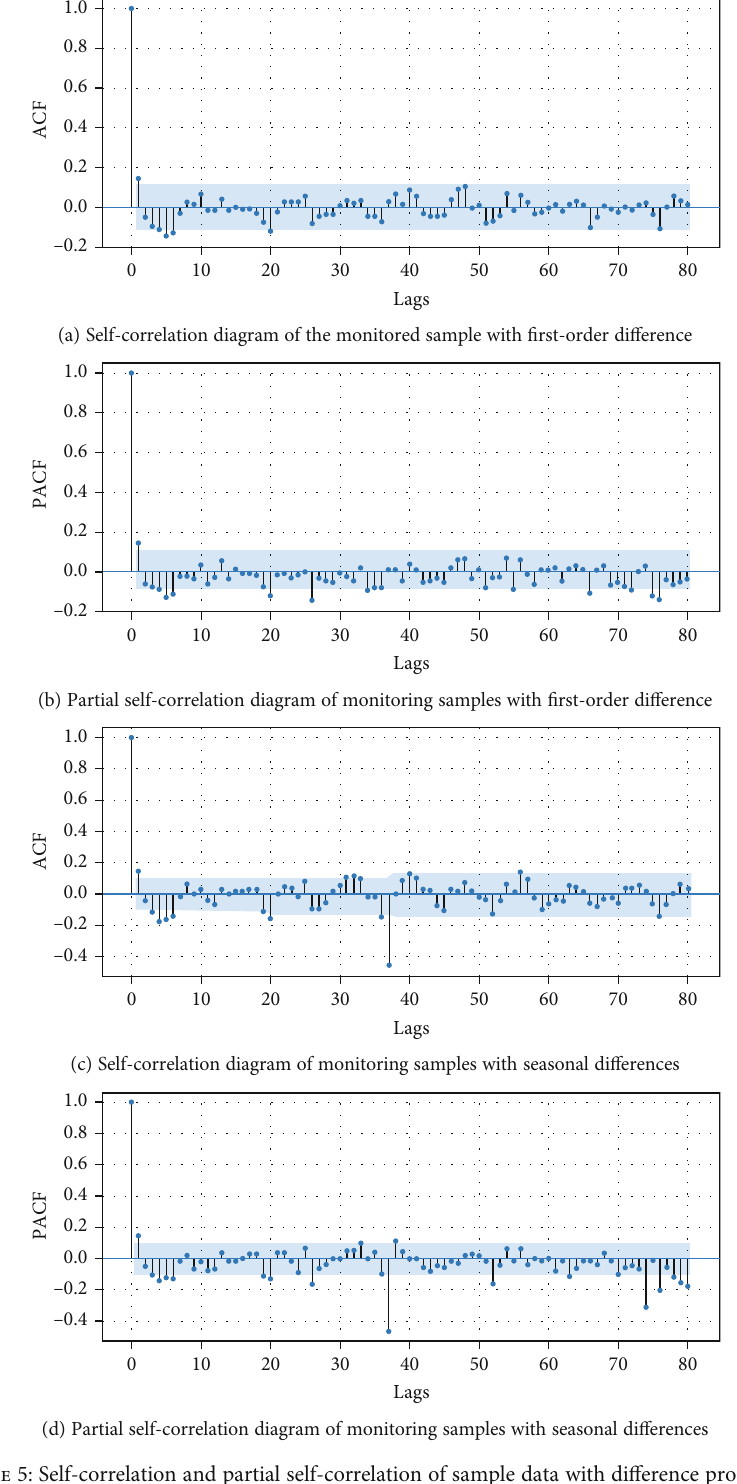
Figure 5: Self-correlation and partial self-correlation of sample data with di ff erence